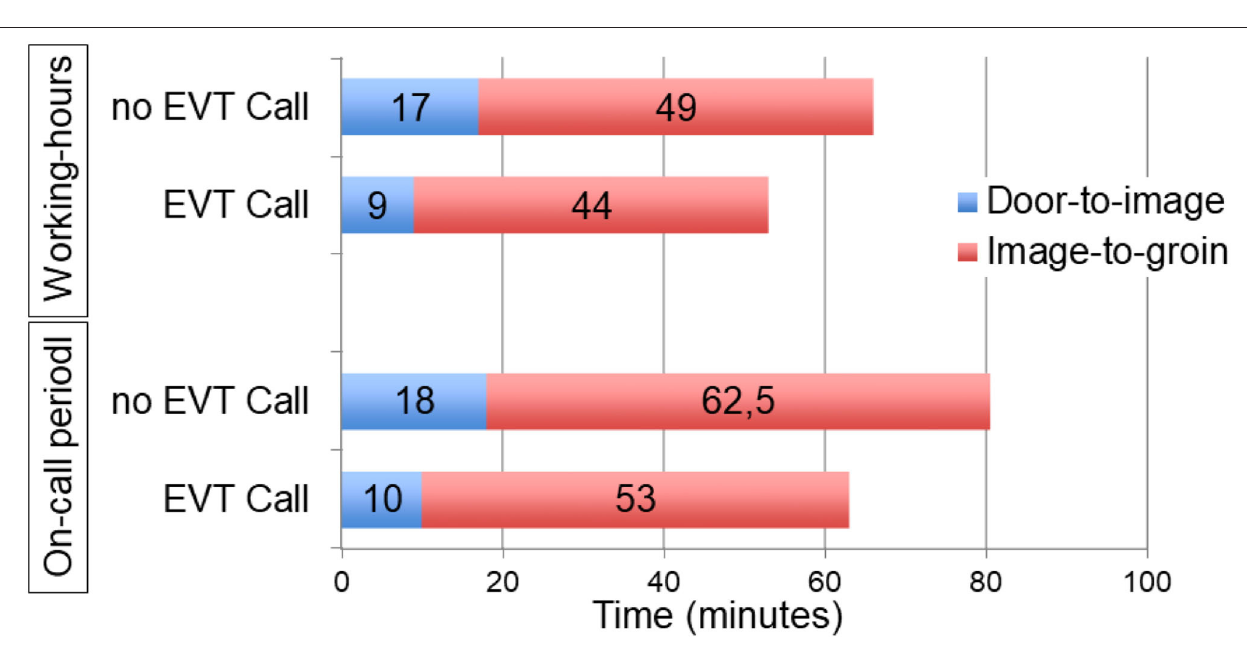
FIGURE 4 | Comparison of median Door-to-image and Image-to-groin times before and after implementation of EVT-call during working-hours and on-call periods.